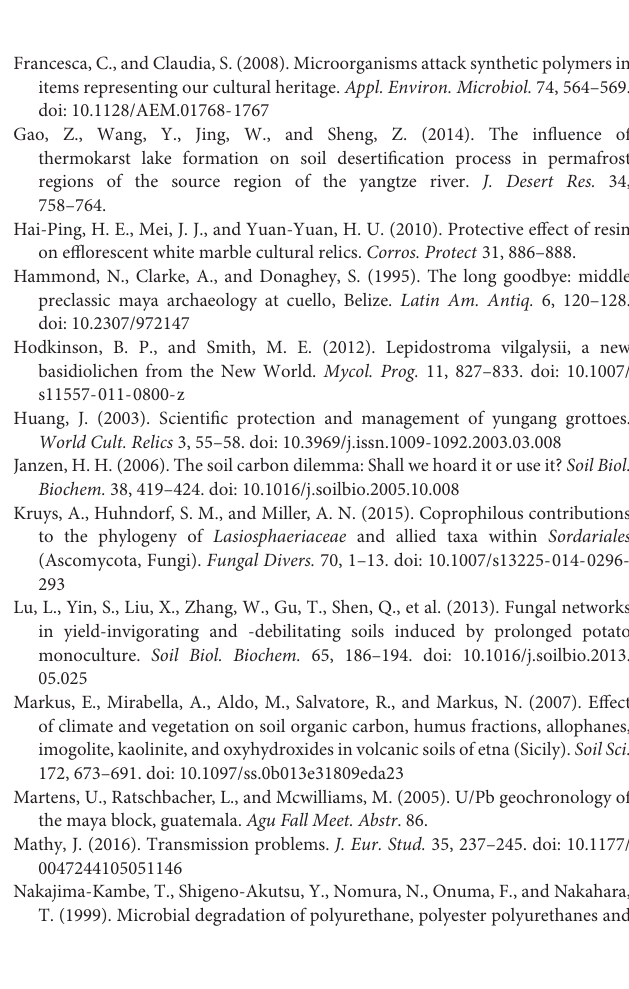
FIGURE S1 | (A) The red spectrum represents the control group, the other colors are the three experimental groups, and the position of the red circle is 910 cm − 1 . (B) The green spectrum represents the control group, the other colors are three experimental groups, and the position of the red circle is 910 cm − 1